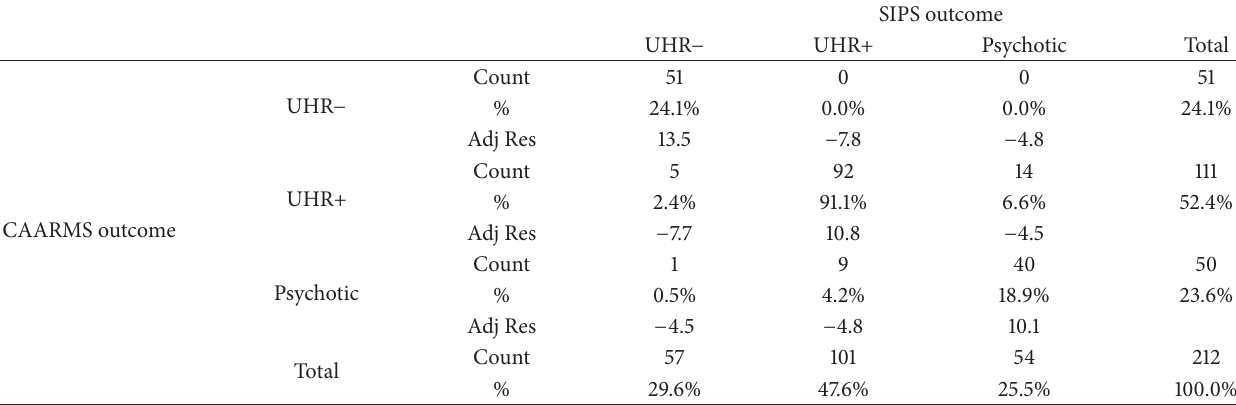
Table 3: Diagnostic comparison between CAARMS 12/2006 and SIPS 0.5 outcomes in subjects seeking help from high-risk services ( 𝑝 < 0.001